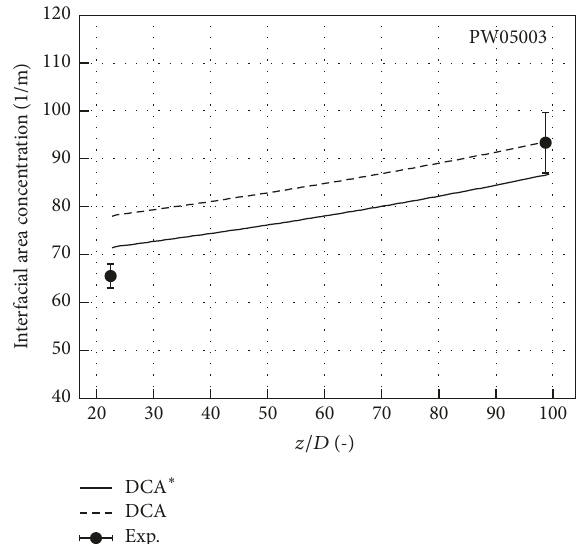
Figure 10: Comparison of interfacial area concentration evolution for the different drag